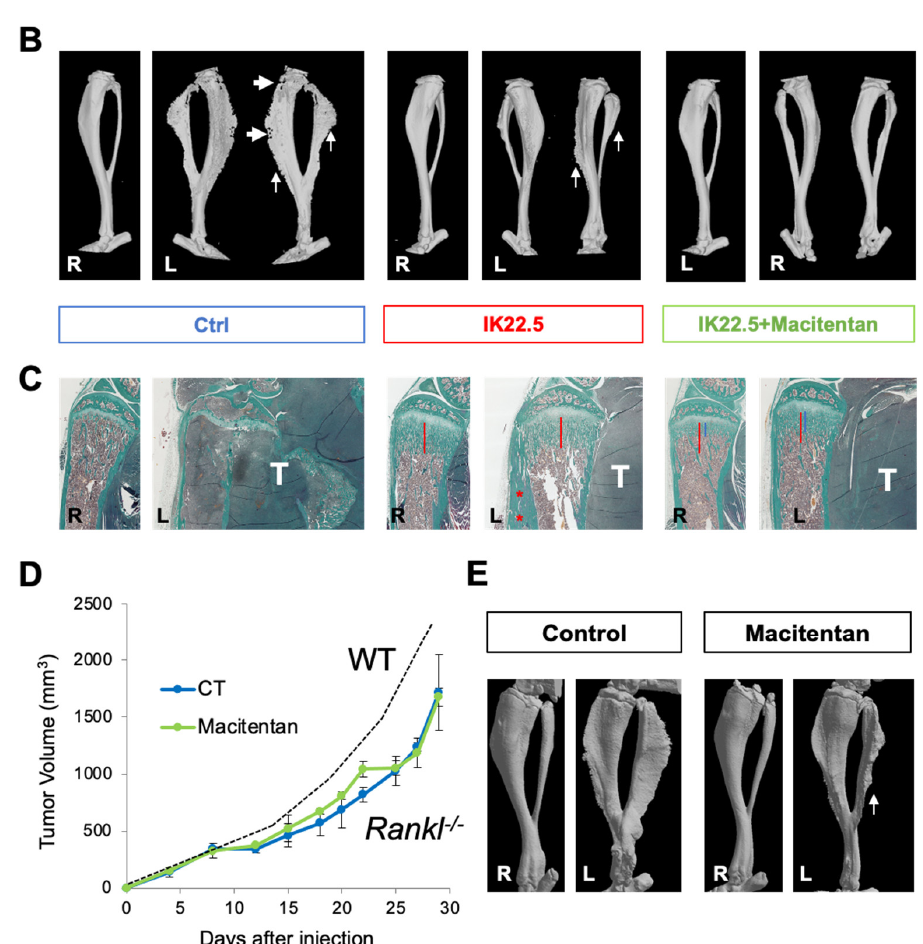
Figure 3. Macitentan (10mg/kg/day) strengthened the bone protective effect of the RANKL blocking antibody (IK22.5) injections in WT mice and reduced tumoral osteoid tissue formation in Rankl -/- mice either injected with MOS-J/PG1 cells. In the aggressive MOS-J/PG1 osteosarcoma model, RANKL inhibition had no significant impact on tumor growth ( A ) but clearly protected the bone from resorption (white arrow-heads in ( B )) and reduced tumoral osteoid tissue formation (white arrows in ( B )). Nevertheless, this treatment induced enlargement in both trabecular bone (red line in ( C )) and cortical bone (red stars in ( C )). Combining macitentan treatment with RANKL inhibition made it possible to reduce this enlargement (blue line in ( C )). The MOS-J/PG1 osteosarcoma model could be applied to Rankl -/- mice (C57BL/6J background) and slightly slower tumor growth was observed compared to WT mice ( D ). Macitentan had no impact on tumor growth in Rankl -/- mice ( D ) but a significant reduction in tumoral osteoid tissue formation was observed (arrow in ( E )) compared to the untreated Rankl -/- control mice ( E ). R: right tibia without tumor; and L: left tibia with tumor.